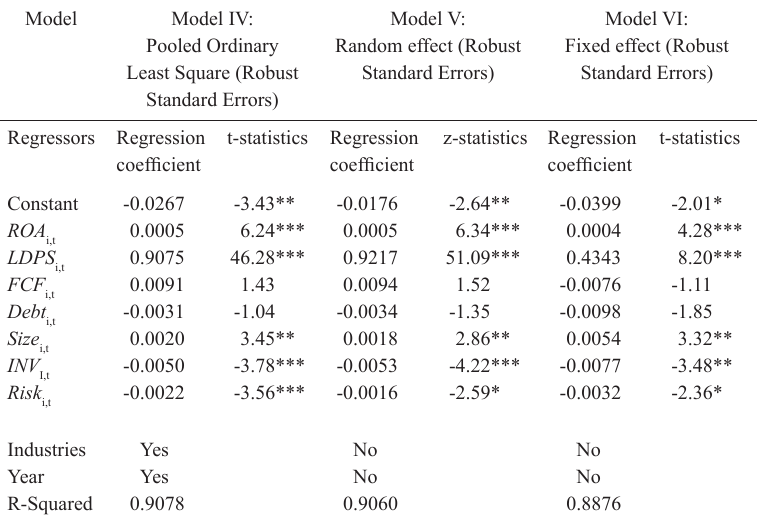
Panel Ordinary Least Square, Random Effect and Fixed Effects (with Robust Standard